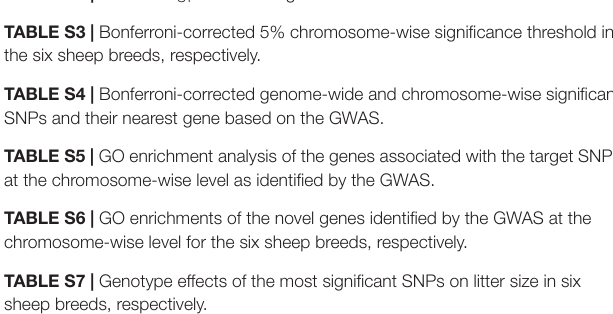
animals from the case group (highly prolific ewes), and the purple dots represent animals in the control group (normally prolific ewes). FIGURE S4 | Q–Q (quantile–quantile) plots of GWAS in (a) Wadi, (b) Hu, (c) Icelandic, (d) Finnish, (e) Romanov, and (f) Texel sheep. Gray and black rings represent association statistics before and after correction for population stratification, respectively. TABLE S1 | Parity effect for litter size and pairwise statistical comparisons between means of litter size in parity’s clades in the six breeds. TABLE S2 | Pairwise F ST value among six